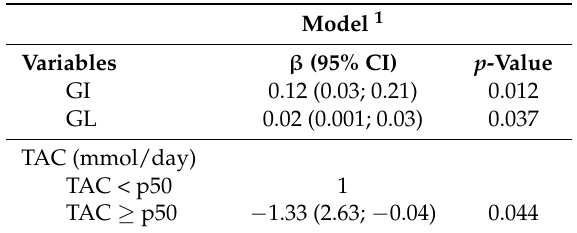
Table 3. Multiple linear regression models with the HOMA-IR as the dependent variable and using biochemical, hepatic, and dietetic factors as independent